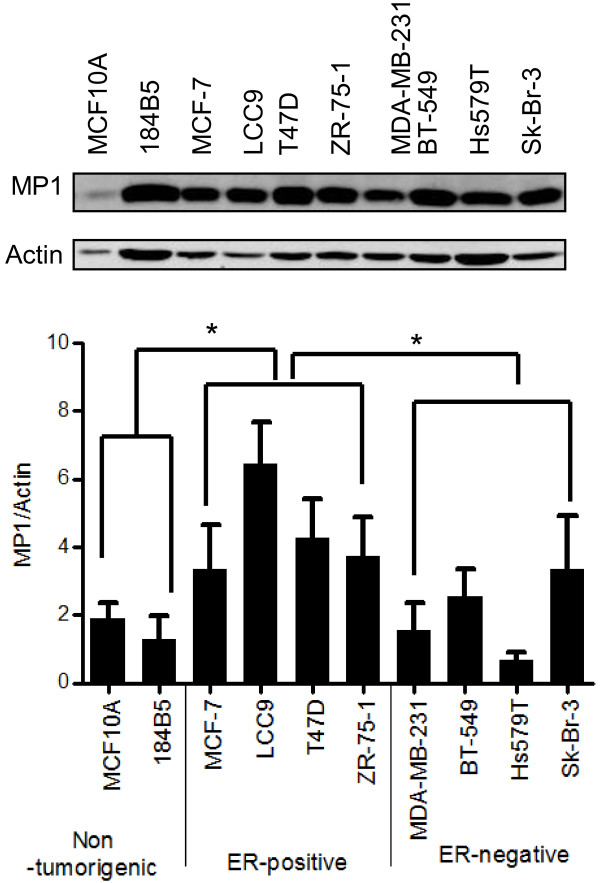
MP1 expression in breast cancer cell lines. Human mammary epithelial cell lines were grown in exponential culture and whole-cell lysates were prepared. Top panel: Immunoblot from a representative experiment. Lower panel: Quantitation of MP1/Actin ratios in three independent experiments (mean ± SD, *p < 0.05). For comparing groups of cell lines, an unpaired two-tailed evaluation was done.